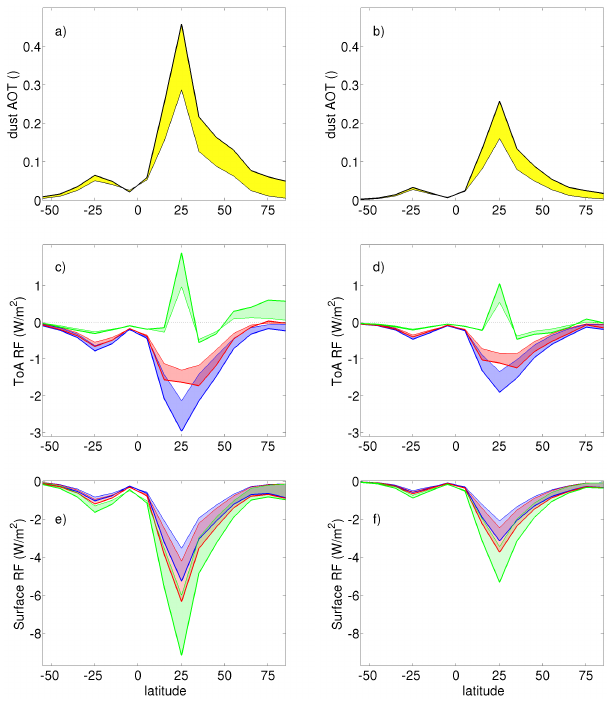
Figure 6. Zonal means from simulations for dust AOT (a, b) , DRF Fig. 6. Zonal means from simulations for dust AOT (a, b) , DRF ( Wm − 2 ) at TOA (c, d) and DRF at (Wm − 2 ) at TOA (c, d) and DRF at surface (e, f) for 21ka (a, c, e) surface (e, f) for 21ka (a, c, e) and 0ka (b, d, f) . Color shading and line width as in Fig. 5. and 0ka (b, d, f) . Colour shading and line width as in Fig.